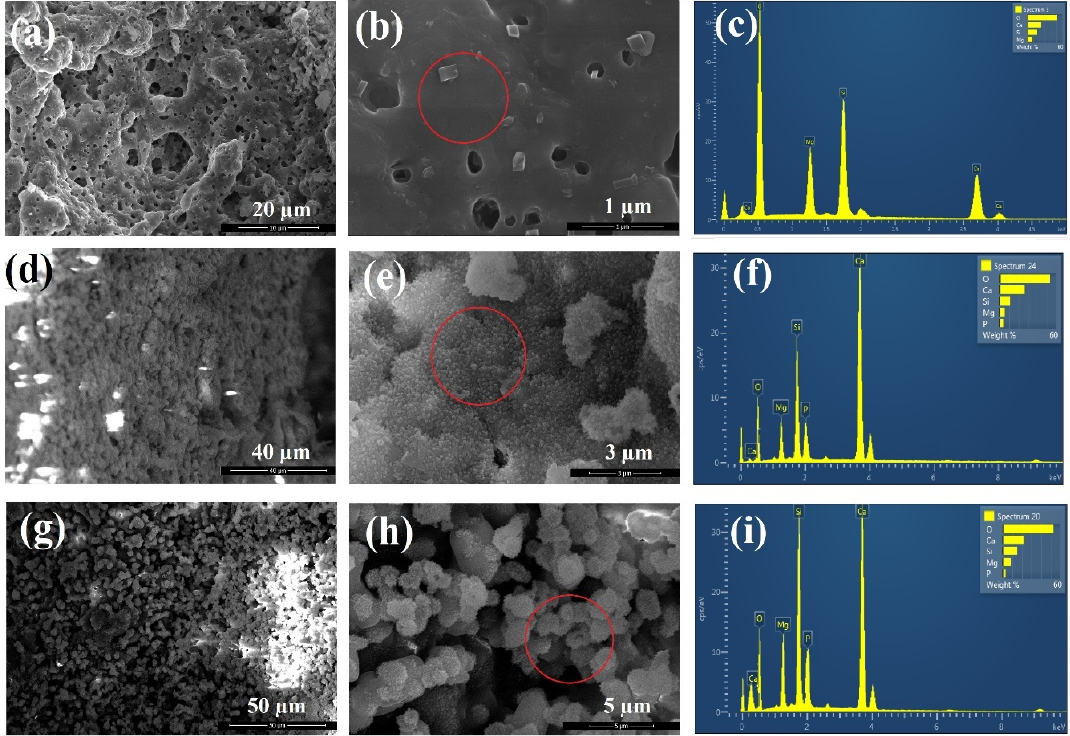
Figure 9. SEM images and EDS spectra of akermanite obtained from 20 h ball milled samples with subsequent annealing at 900 °C for 1 h ( a – c ) before, ( d – f ) after 14 days and ( g – i ) after 28 days soaking in SBF solution.